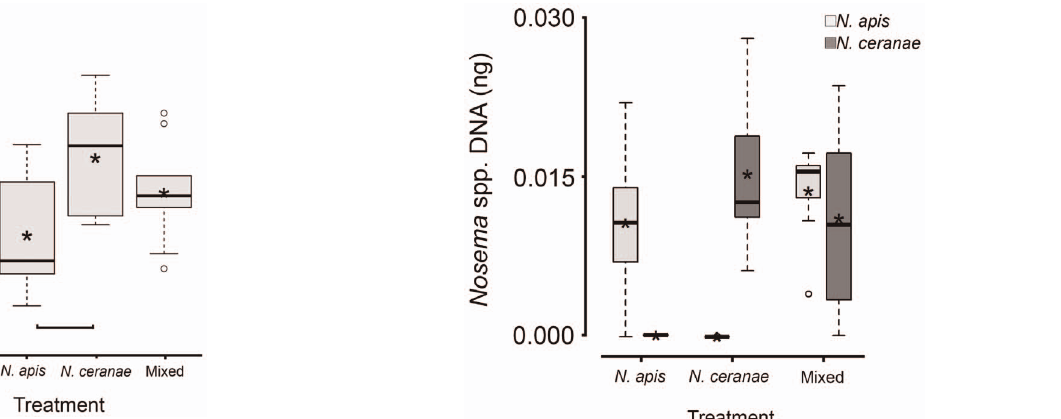
Figure 4. Levels of Nosema apis and Nosema ceranae DNA (square root-transformed) in adult worker western honey bees ( Apismellifera ) that died between 28 and 30 d post inoculation in N. apis , N. ceranae or mixed N. apis / N. ceranae treatments (same workers shown in Fig. 3). Boxplots show interquartile range (box), median (black or white line within interquartile range), data range (dashed vertical lines), and outliers (open dots); asterisks (black or white) represent means. No significant differences were observed in quantities among the four instances where we expected to find DNA (i.e., the boxes with means above 0).